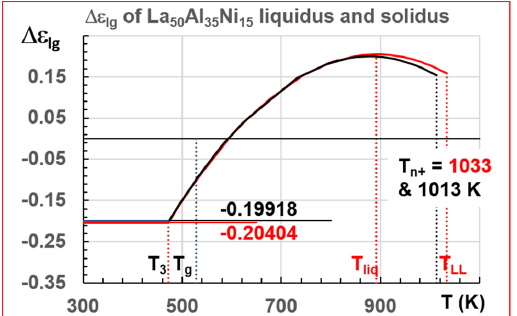
Figure 17. La 50 Al 35 Ni15 enthalpy coefficients of liquidus and solidus melts. T sol = 877.6 K; T n+ = 1013 K; T liq = 892 K; T n+ = T LL = 1033 K. The enthalpy coefficients of ultrastable phase 3 are (−0.19918) for the solidus and (−0.20404) for the liquidus. The two melts have the same T g = 574 K.